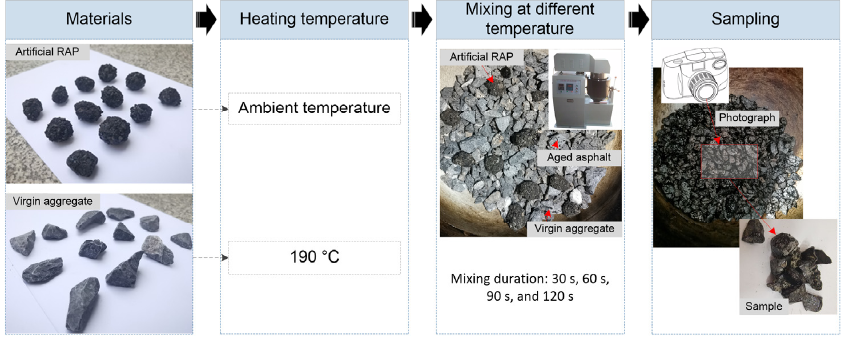
Figure 3. Test process for aged asphalt distribution with different mixing durations.